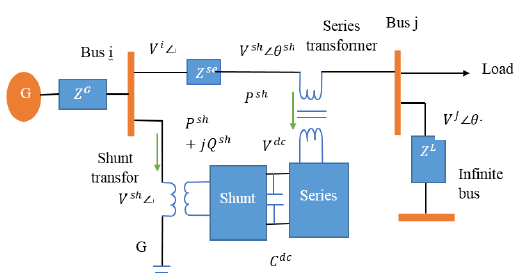
Figure 1. Mathematical design of UPFC